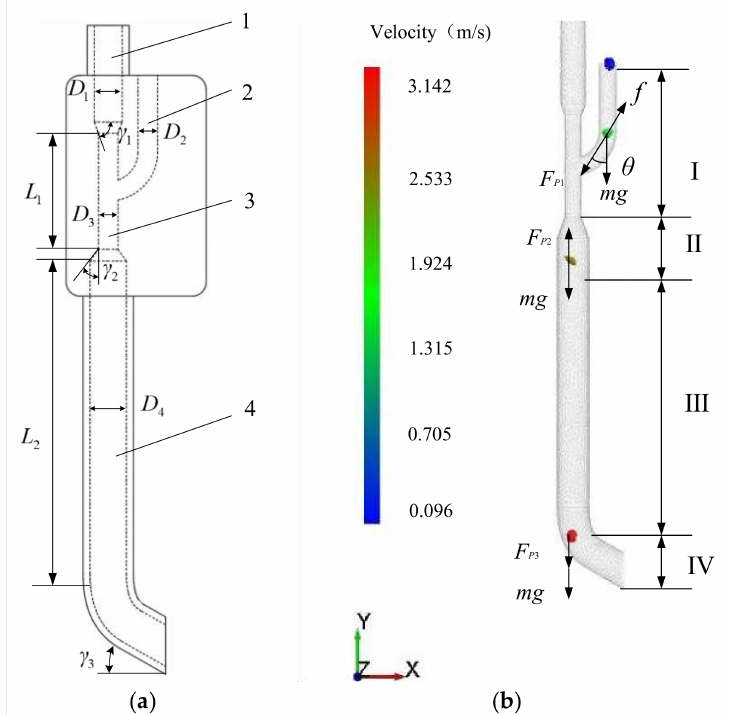
Figure 2. Schematic diagram of the structure of the seed-delivery system. ( a ) 1—Air inlet chamber, 2—intake seed chamber, 3—mixing chamber, and 4—delivery chamber. ( b ) Analysis of seed